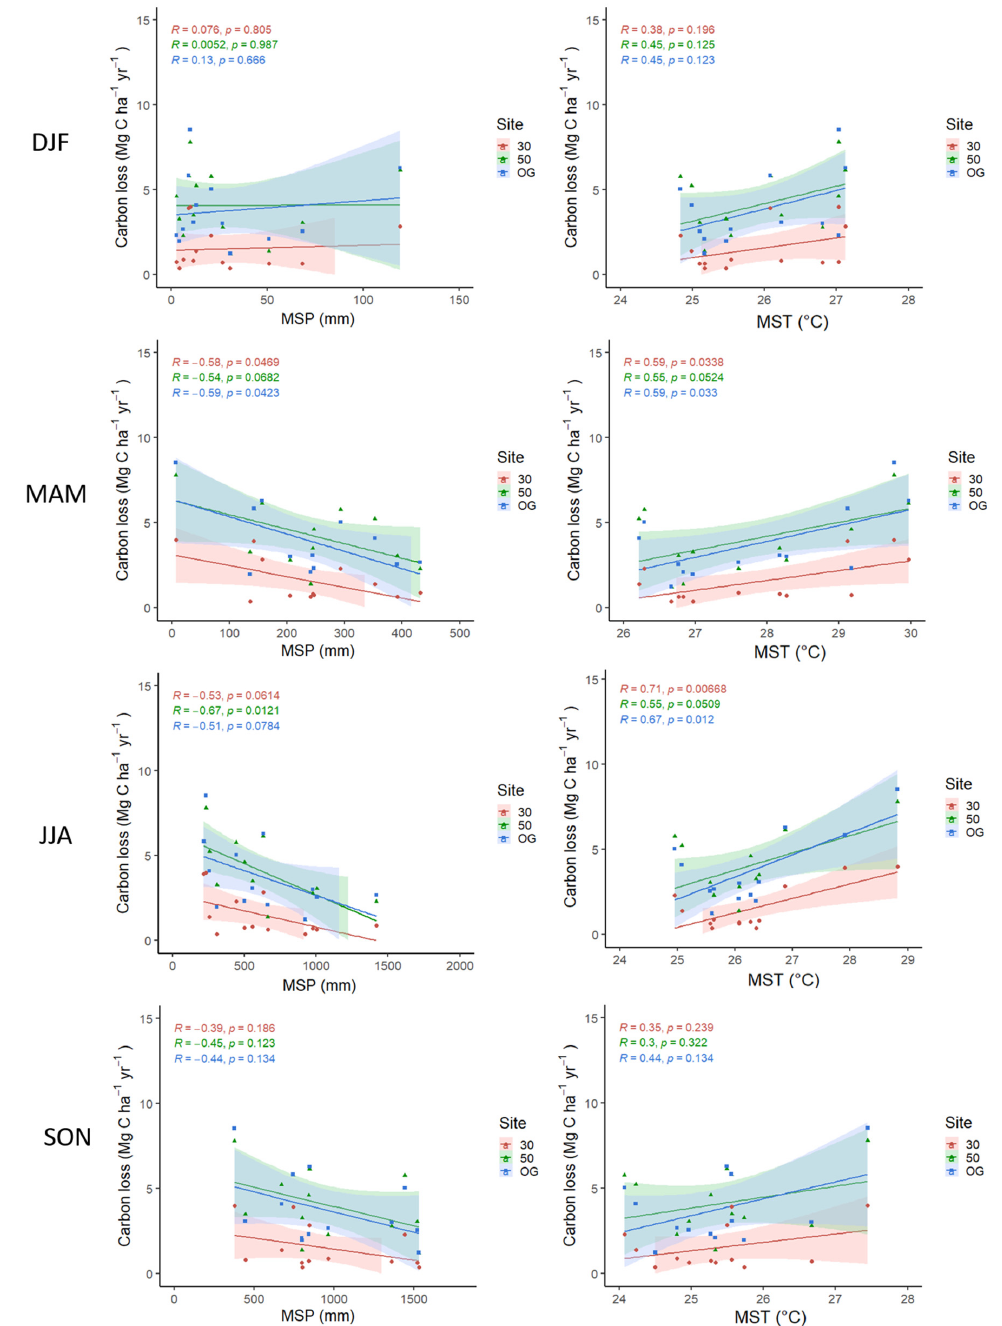
Figure 6. Linear relationship between carbon losses, mean seasonal temperature (MST), and mean seasonal precipitation (MSP) in Santa Rosa National Park SRNP. DJF (December to February), MAM (March to May), JJA (June to August), SON (September to November), and DJF (December to February).